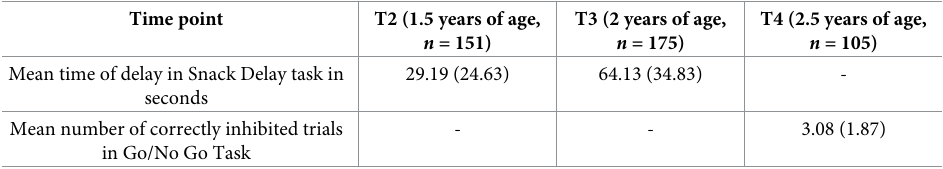
Table 2. Descriptive statistics of inhibitory control tasks (SD in parentheses).